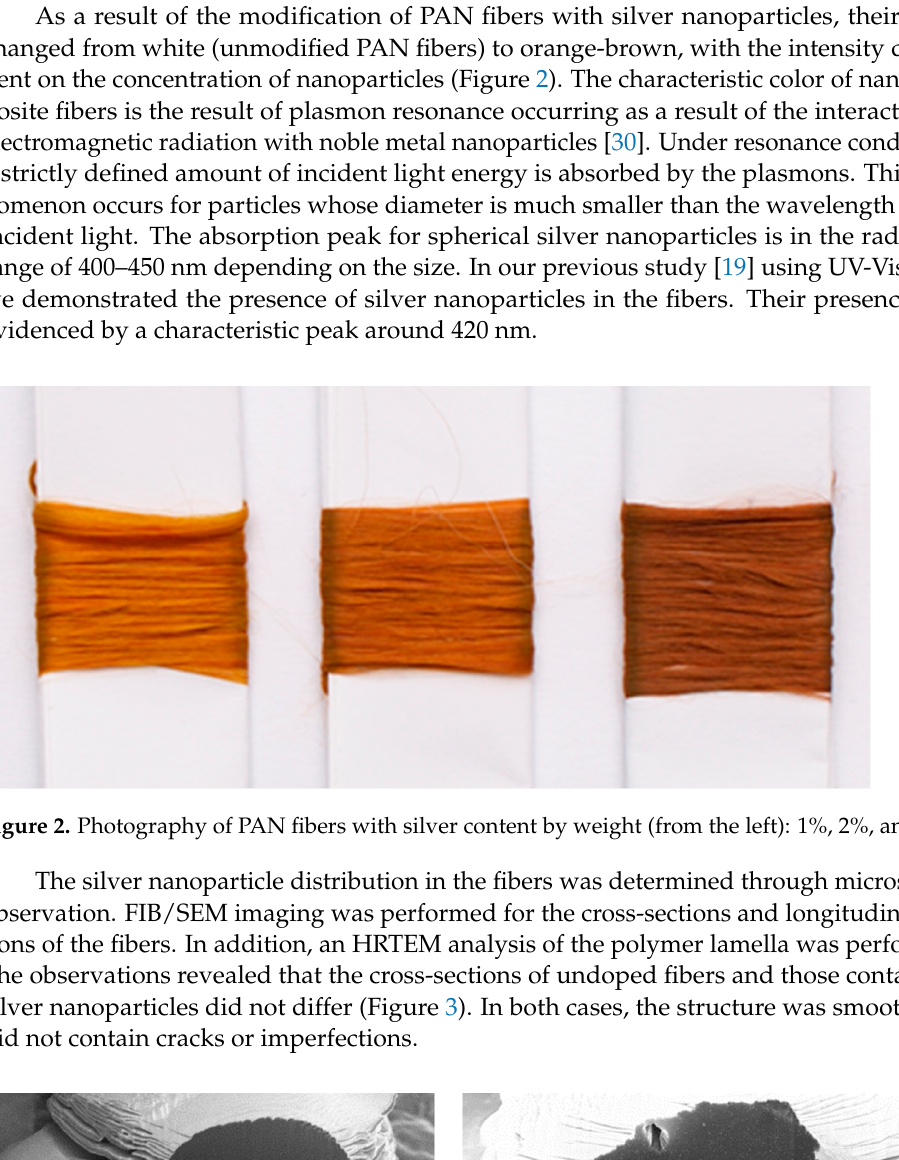
( b ) Figure 4. Distribution of nanoparticles in PAN fi bers: ( a ) cross-section; ( b ) longitudinal section. HRTEM microscopic analysis showed that the silver nanoparticles were distributed in the form of clusters consisting of particles with a diameter of about 20 nm (Figure 5).